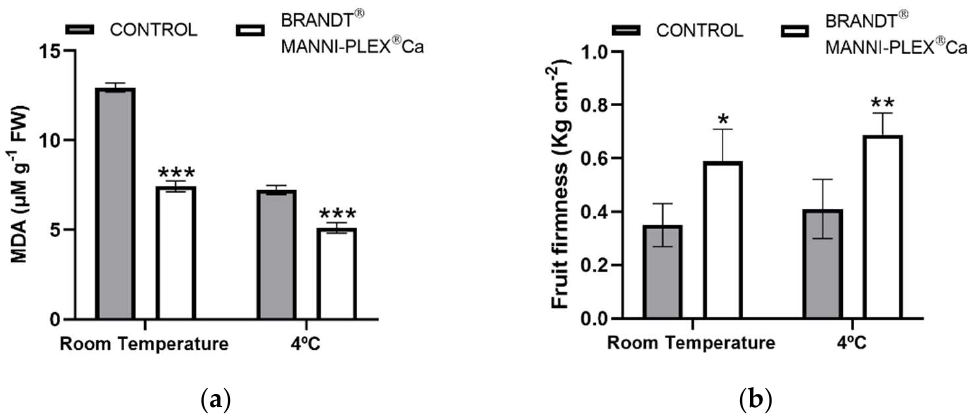
Figure 3. Effect of the application of BRANDT ® MANNI-PLEX ® Ca on the concentration of MDA ( a ) and on the firmness of pepper ( b ) in pepper fruits subjected to post-harvest at room temperature and 4 °C. Values are expressed as means ± standard error ( n = 9). The levels of significance were represented by p < 0.05 (*) and p < 0.001 (***).